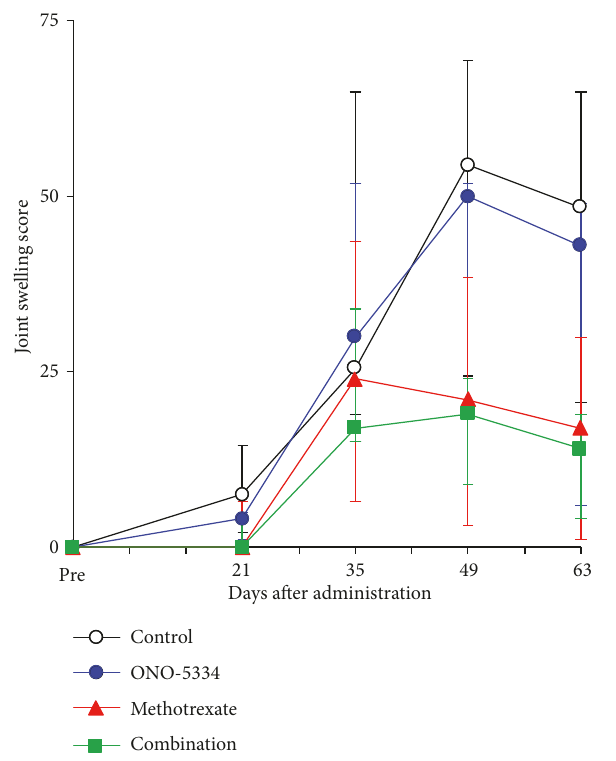
Figure1:Jointswellingscoreincollagen-inducedarthritismonkeys. The swelling levels of DIP, PIP, and MP joints in 5 digits of the forelimbs and hindlimbs as well as wrist, ankle, elbow, and knee joints in individual animals were evaluated in a blinded manner in accordance with the following criteria: score 0: no abnormality; score 1: swelling not visible but can be determined by touch; score 2: swelling slightly visible and can be confirmed by touch; score 3: swelling clearly visible; score 4: rigidity of the joints. The maximum score is 256 (total 64 joints/body and arthritic scores 0–4). Data are expressed as median (quantile 3-1); control (n=8), ONO-5334 (n=9), methotrexate (n=8), and combination (n=9).